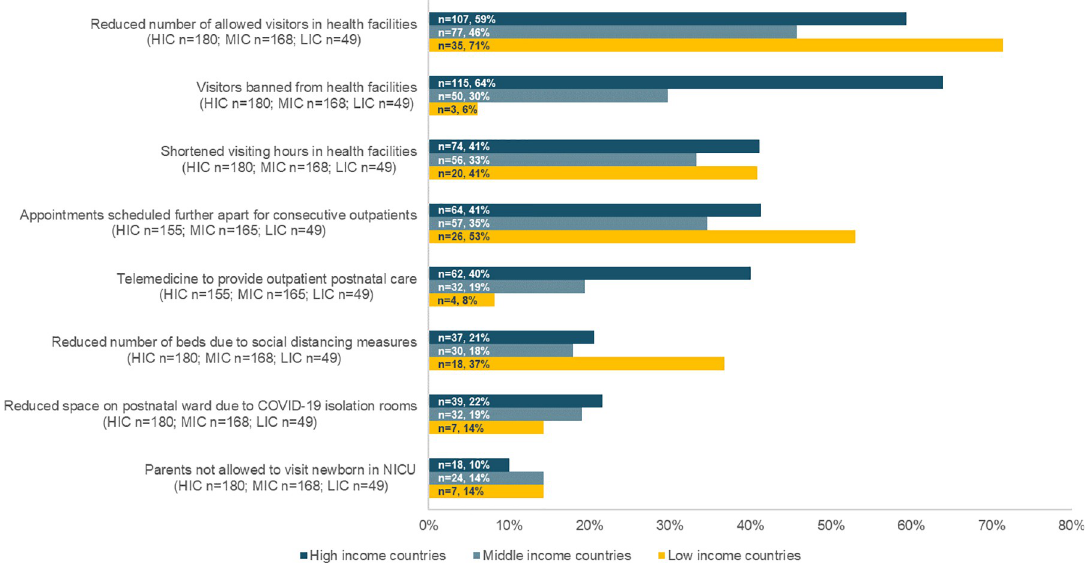
Fig 1. Number and percentage of respondents reporting adaptations in the process of postnatal care aiming to reduce the risk of SARS-CoV-2 transmission, by country income level during the month preceding the survey.